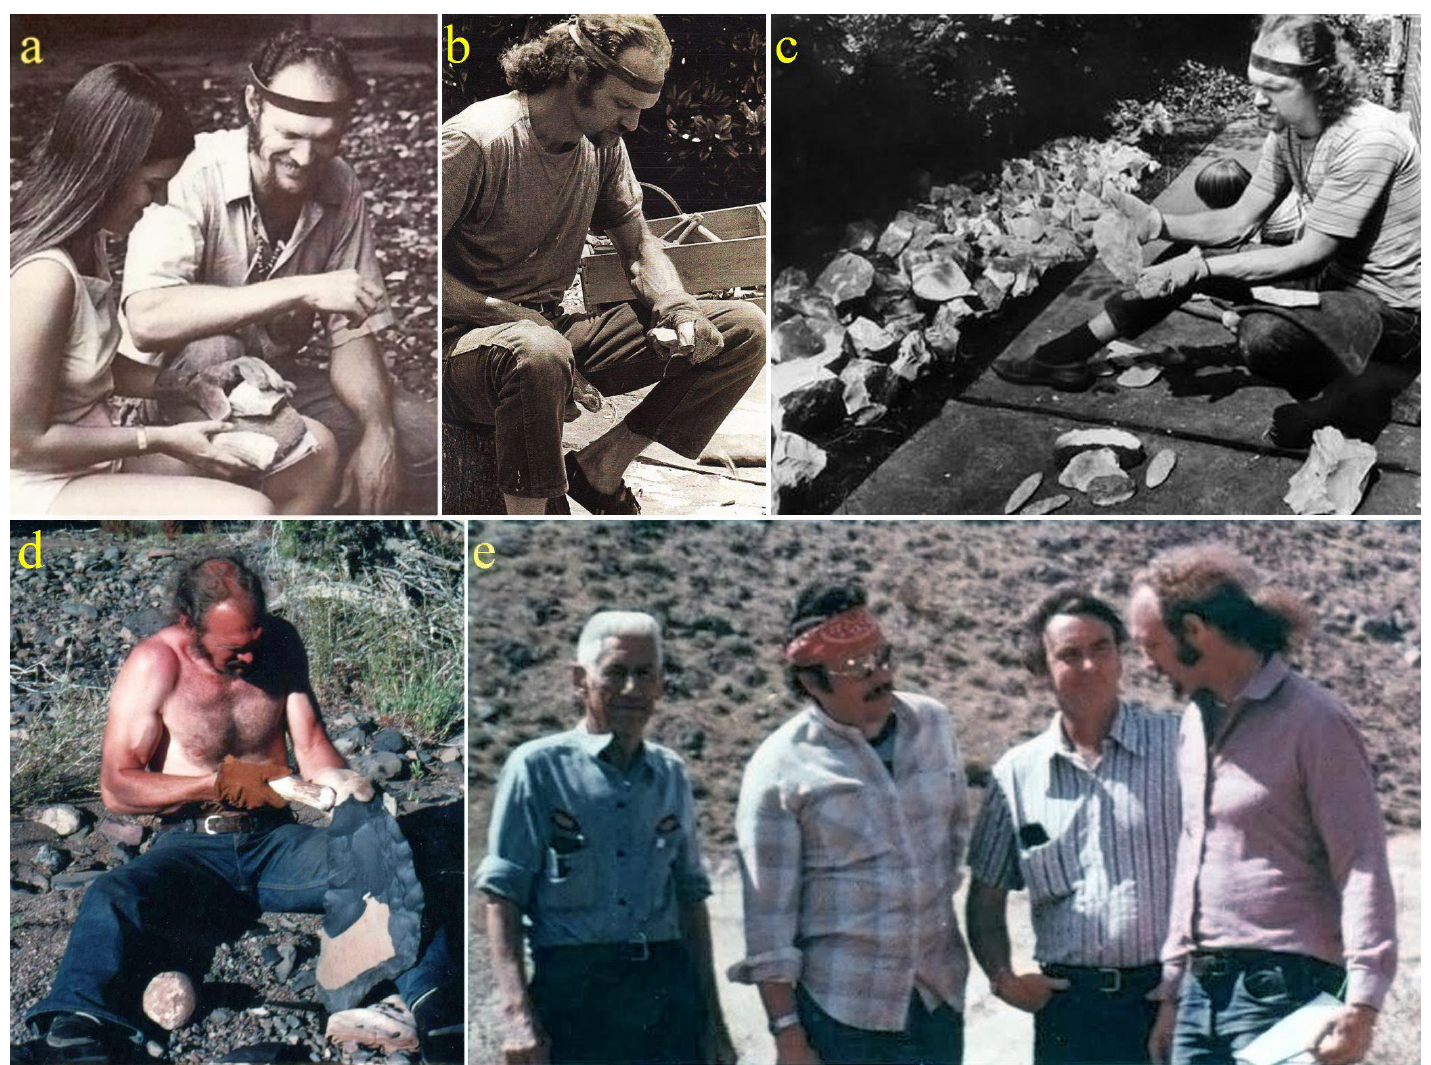
Figure 1. Errett during the 1970s. a) teaching flintknapping at Virginia Commonwealth University ), b-c) flaking and showing a biface, d) working a large basalt biface, e) from left to right, with J. Sollberger, J. Flenniken, and G. Titmus in 1978. (Photos by courtesy of R.